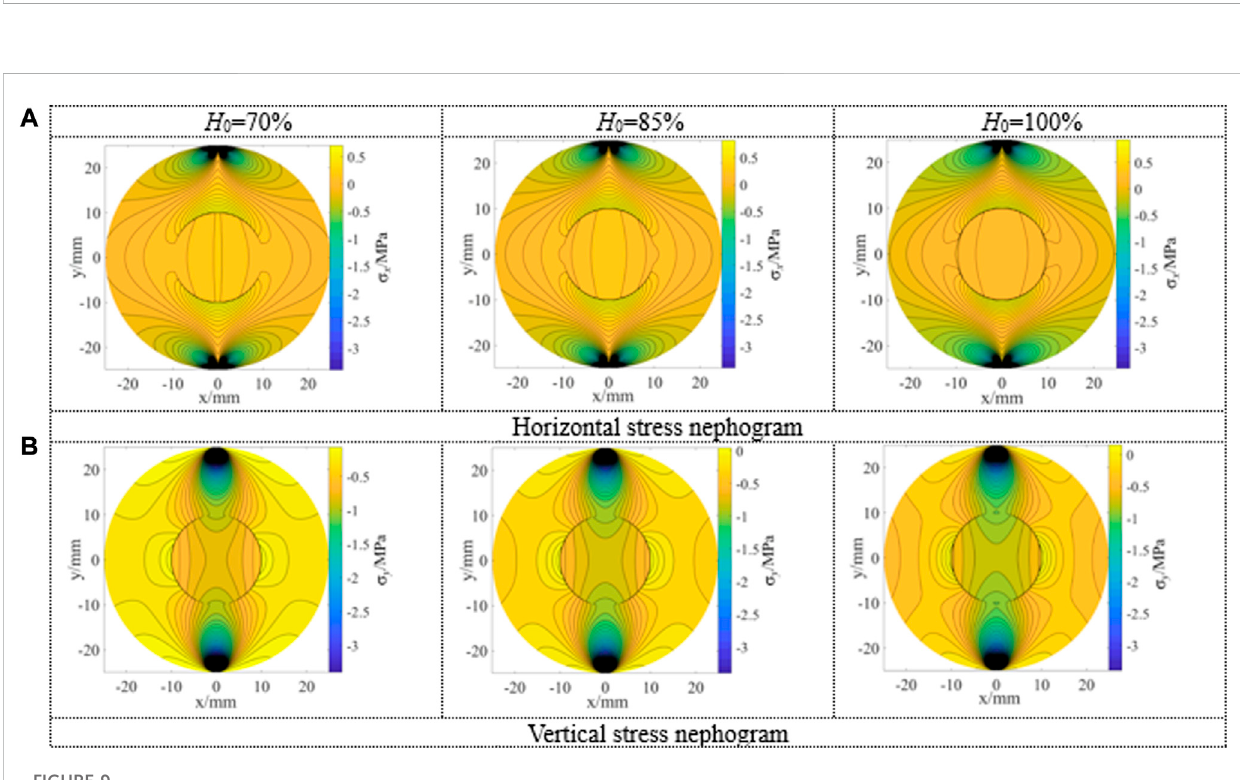
FIGURE 9 Stress nephogram of the disc under the in fl uence of the humidity fi eld (Zhao et al., 2020b). (A) Horizontal stress nephogram. (B) Vertical stress nephogram.